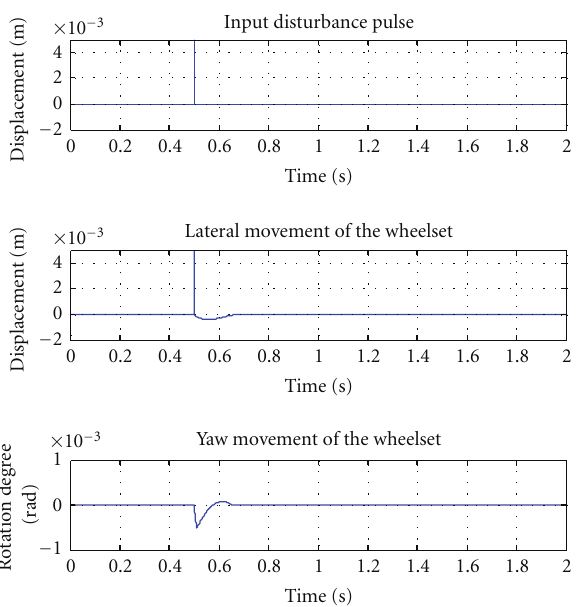
Figure 8: A wheelset with active motor control at 50m/s running